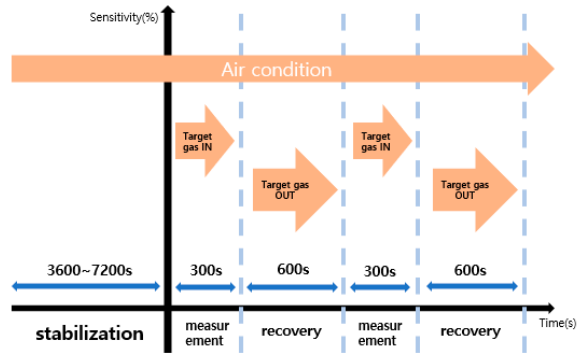
Figure 3. Gas sensor sensitivity evaluation in progress.